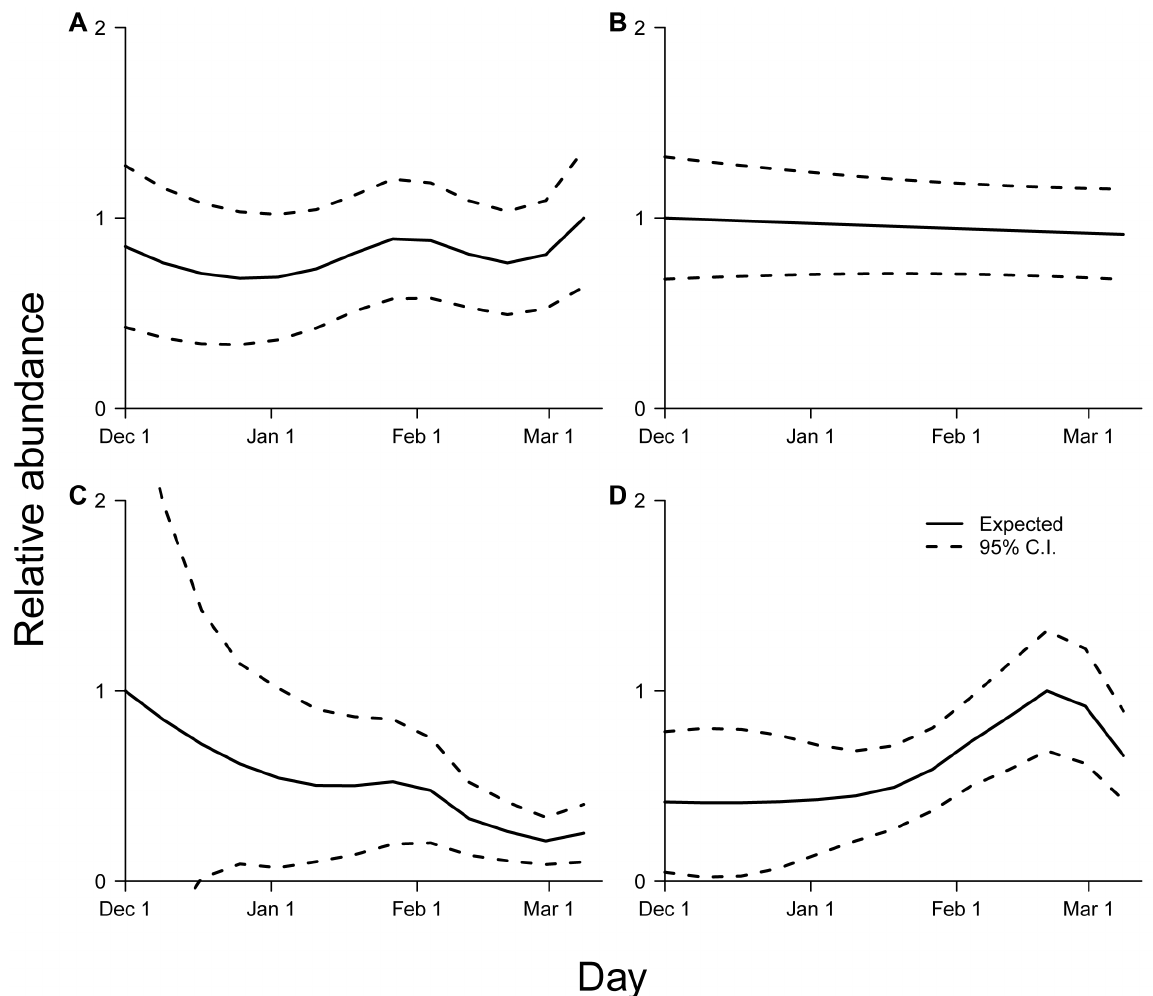
Figure 2. Within-season temporal variation in bat counts. Relative abundance and approximate 95% confidence intervals during December- March for (A) M. lucifugus , (B) P. subflavus , (C) M. sodalis , and (D) M. septentrionalis . Relative abundance was set equal to 1.0 at the maximum expected value.